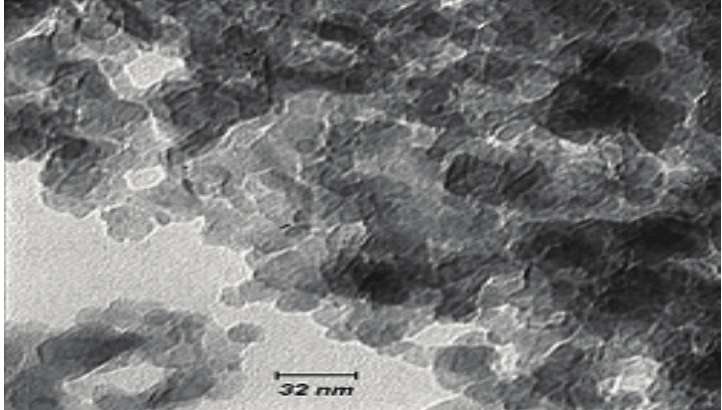
Figure 1. TEM micrograph of nano- sized